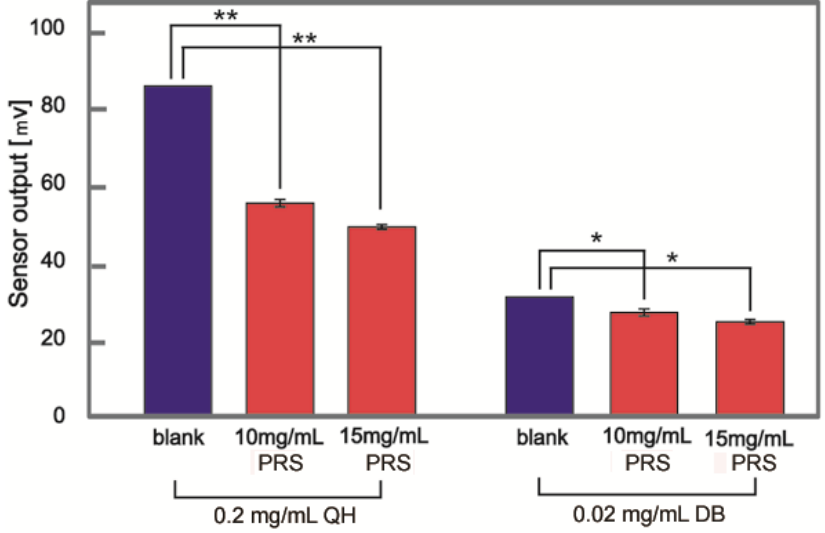
Figure 1. The bitterness of QH and DB in the absence and presence of powdered roasted soybean (PRS) measured as the change in the membrane electric potential of a taste sensor. The reference potential was obtained by immersing the sensor electrode in a 30 mM KCl solution. The bars represent mean ± SD, n = 5, * p < 0.05, ** p < 0.01.